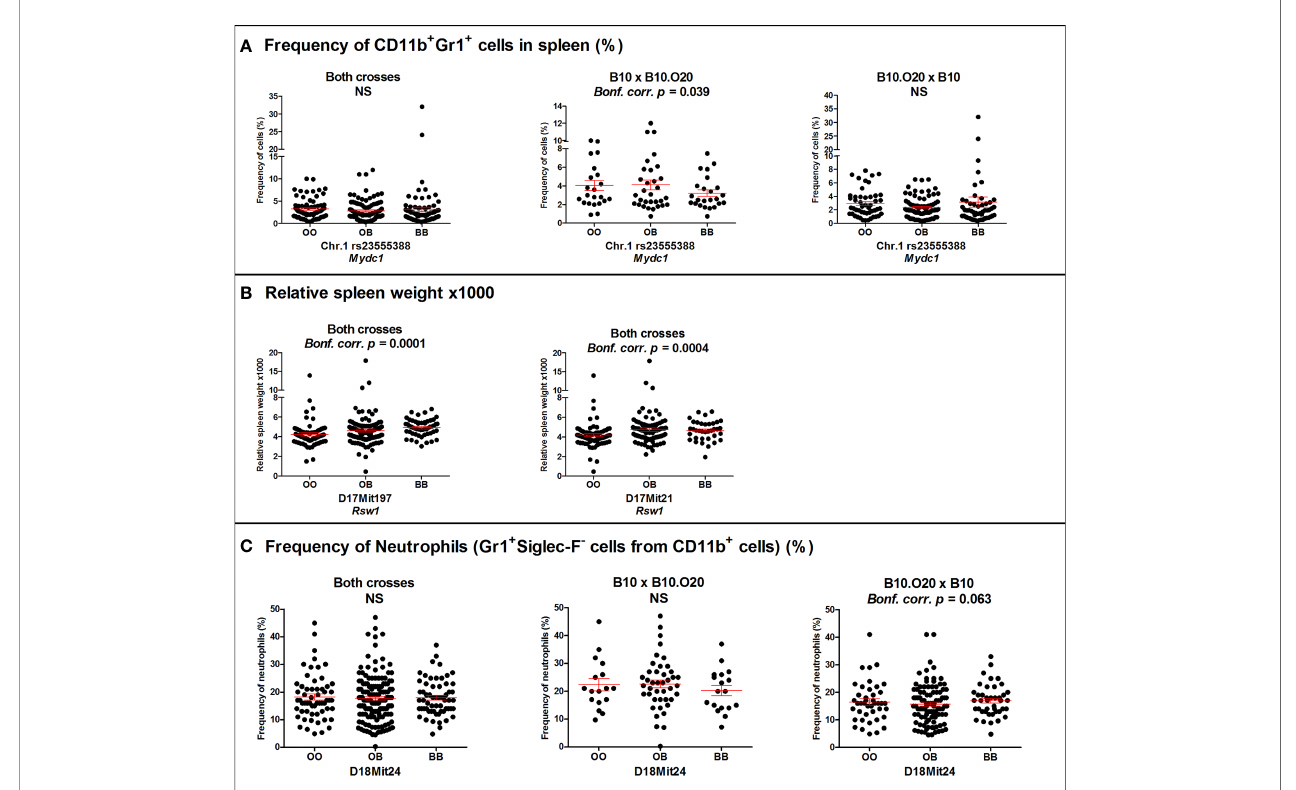
FIGURE 3 | Genetic in fl uence on frequency of (A) CD11b + Gr1 + cells, (B) relative spleen weight, and (C) neutrophils. Individual F 2 hybrid mice between strain B10.O20 and B10 are shown. Means ± standard error mean (red lines) and p -values were calculated by analysis of variance (ANOVA). O and B indicate the presence of O20 and B10 allele, respectively. NS, Not signi fi cant.